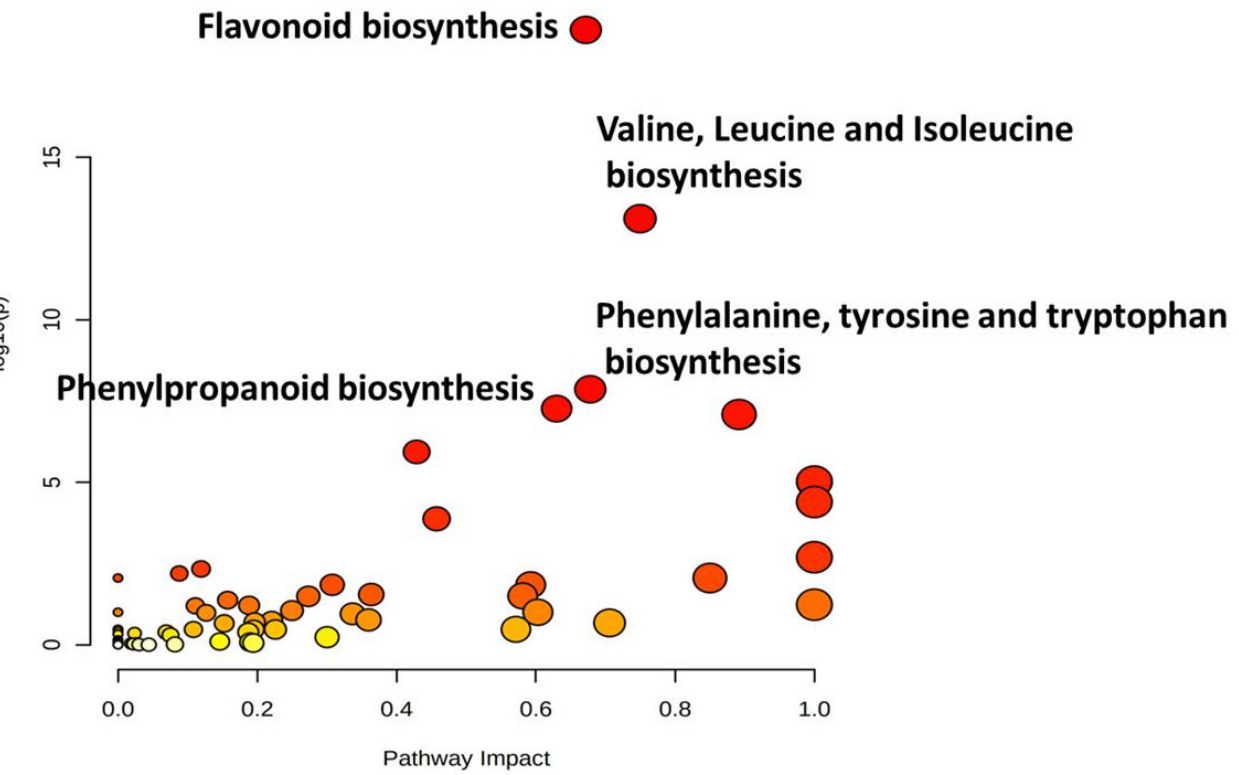
Figure 11. Major pathways contributing towards diversification of grain color in sorghum.